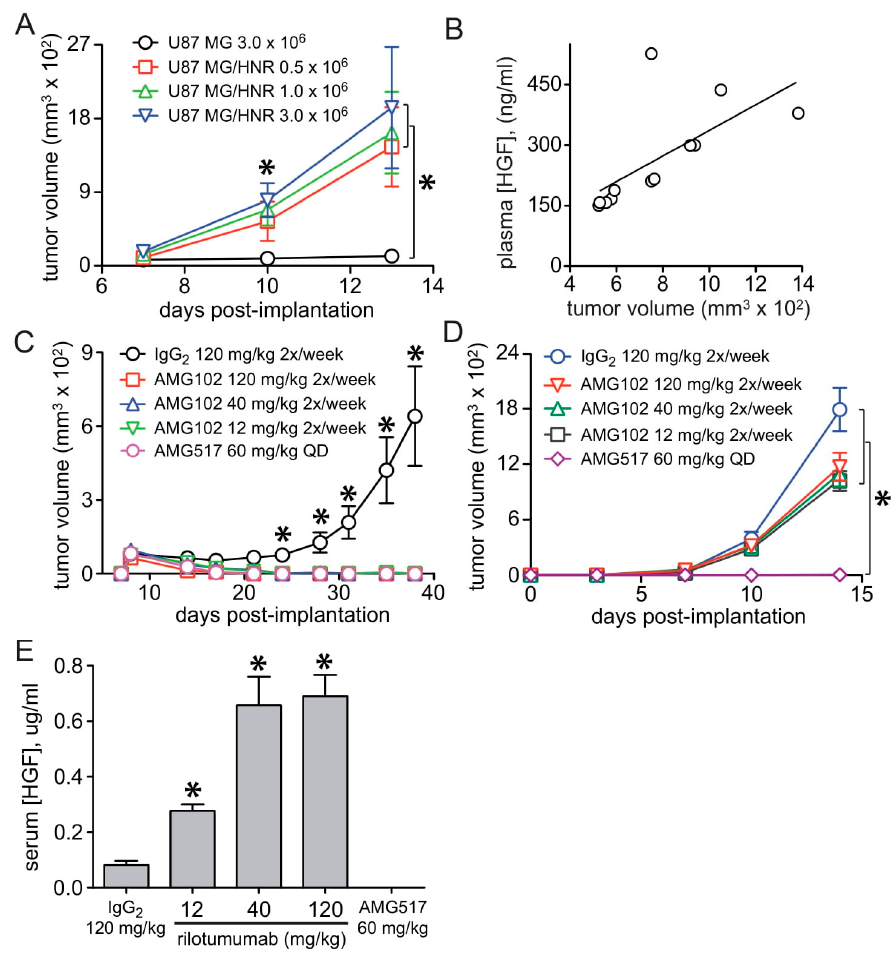
Figure 2. Rilotumumab-resistant U87 MG/HNR cell xenograft growth remains HGF-pathway dependent. ( A ) Tumor xenograft growth (mean tumor volume ± SEM, n = 10) in mice implanted with U87 MG (circles, 3 × 10 6 cells/animal) or U87 MG/HNR cells (squares, triangles and inverted triangles) at 0.5, 1 or 3 × 10 6 cells/animal, respectively. ( B ) Mean plasma HGF concentration (ng/mL) vs. tumor volume for mice implanted with U87 MG/HNR cells. ( A , C ) U87 MG tumor xenograft (5 × 10 6 cells/mouse) growth in mice (mean tumor volume ± SEM, n = 10) treated with control IgG (black circles) or rilotumumab (AMG102) at 12 (green inverted triangles), 40 (blue triangles) or 120 mg/kg (red squares) or compound A at 60 mg/kg (violet circles). ( D ) U87 MG HNR xenograft growth (0.5 × 10 6 cells/mouse, mean tumor volume ± SEM, n = 10) in mice treated with control IgG (circles) or rilotumumab (AMG102) at 12 (squares), 40 (triangles) or 120 mg/kg (inverted triangles) or the small-molecule kinase inhibitor AMG517 at 60 mg/kg (diamonds). ( E ) Mean ( ± SD) serum HGF concentration ( µ g/mL) at study termination in U87 MG/HNR tumor-bearing mice treated as in panel ( D ). Asterisks indicate a significant difference from control ( p <